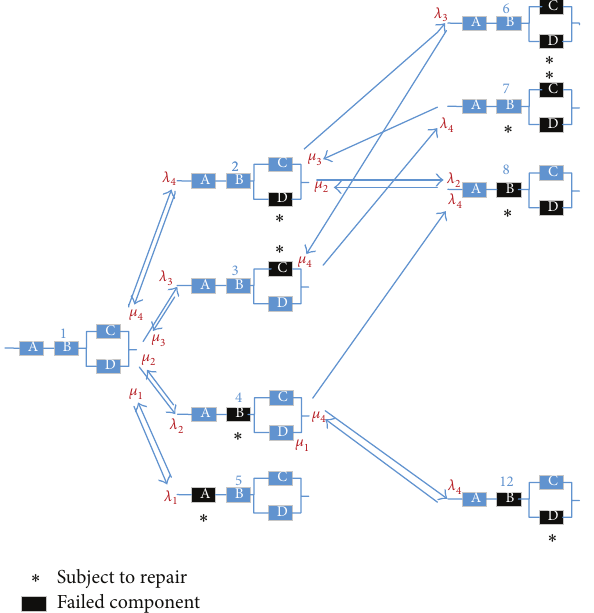
Figure 4: Simplified state transition diagram obtained by means of GPT.